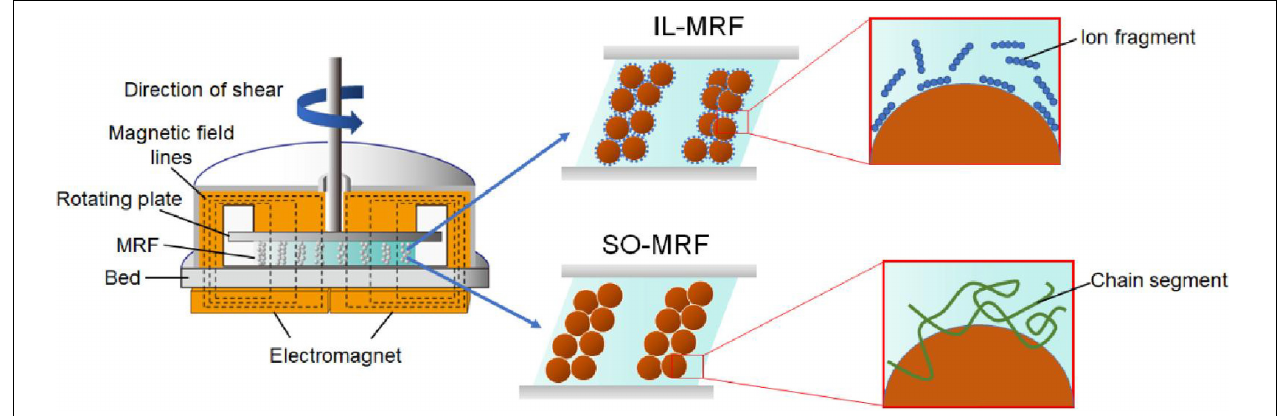
FIGURE 4 | Imaginary schematic diagram of the interface of SO-MRF and